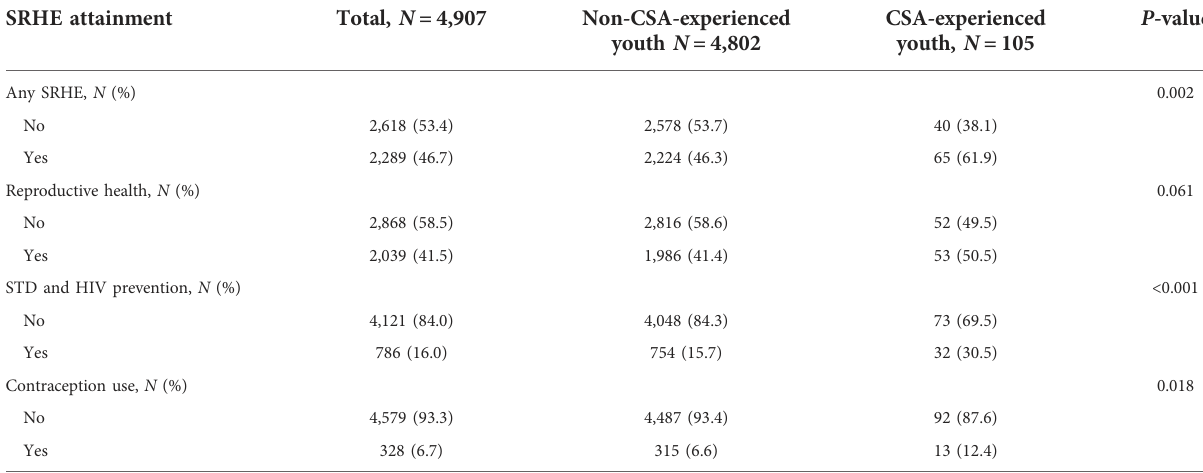
TABLE 2 SRHE of Chinese youth by CSA experience.